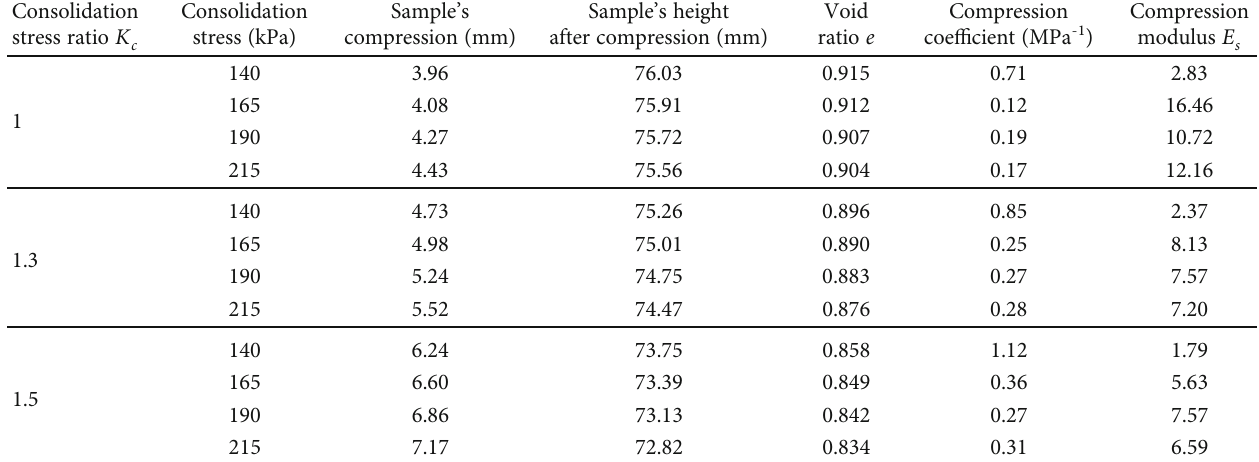
Table 4: Calculation results of mechanical parameters of normally consolidation clay during consolidation.